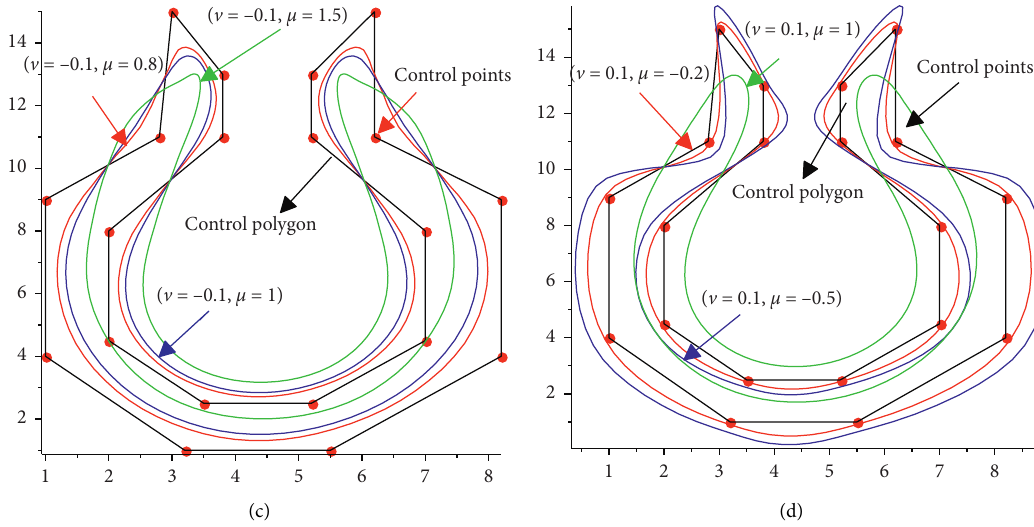
Figure 4: Coloured lines show the curves fitted by the combined subdivision schemes.